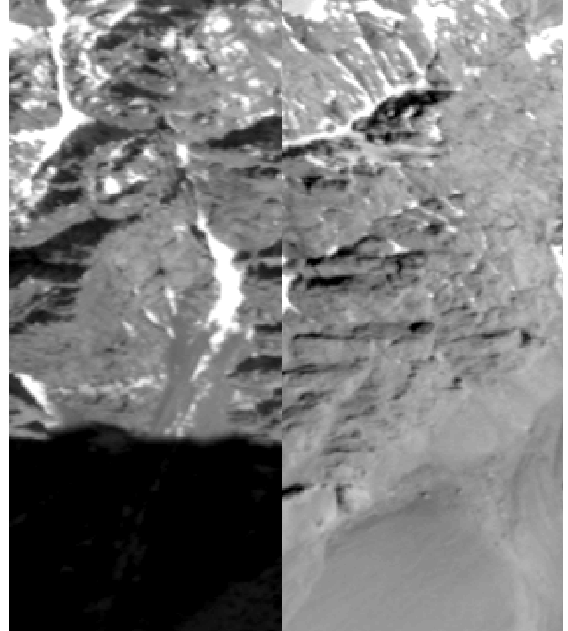
Figure 11. The accuracy of plane edge connection exceeds the